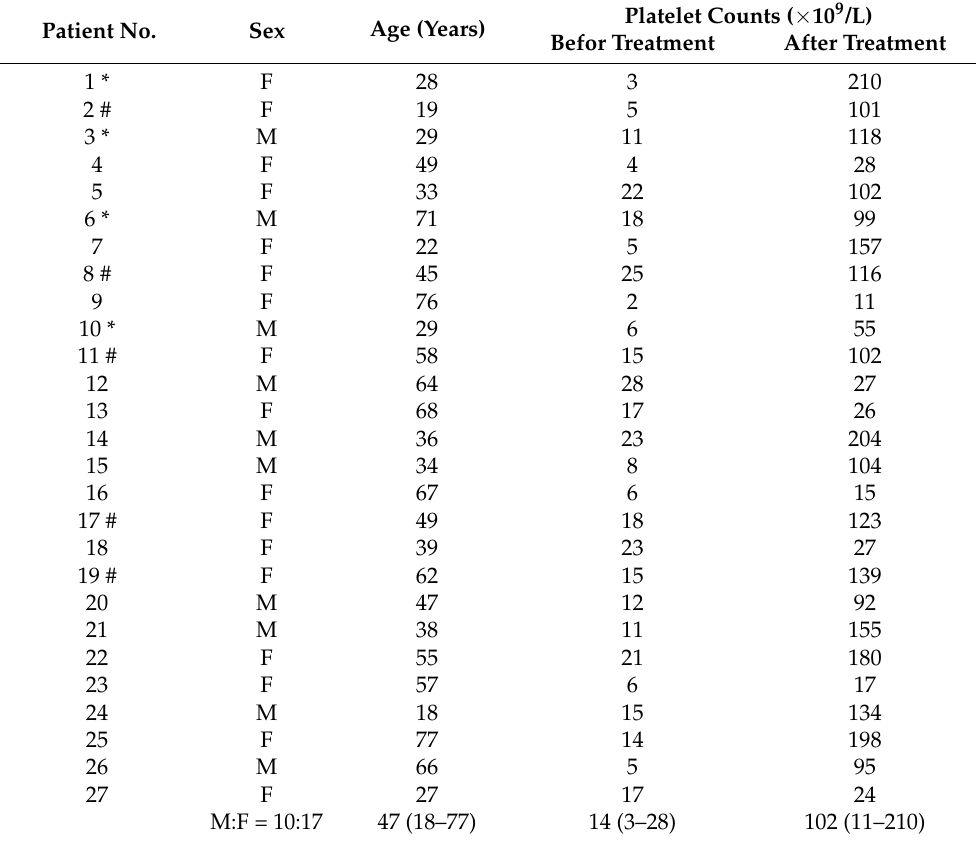
Table 1. The characteristic of enrolled patients. Patient